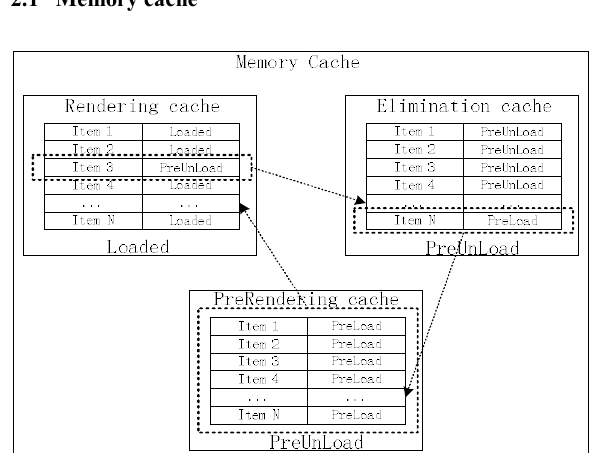
Figure 1. Data transfer in memory